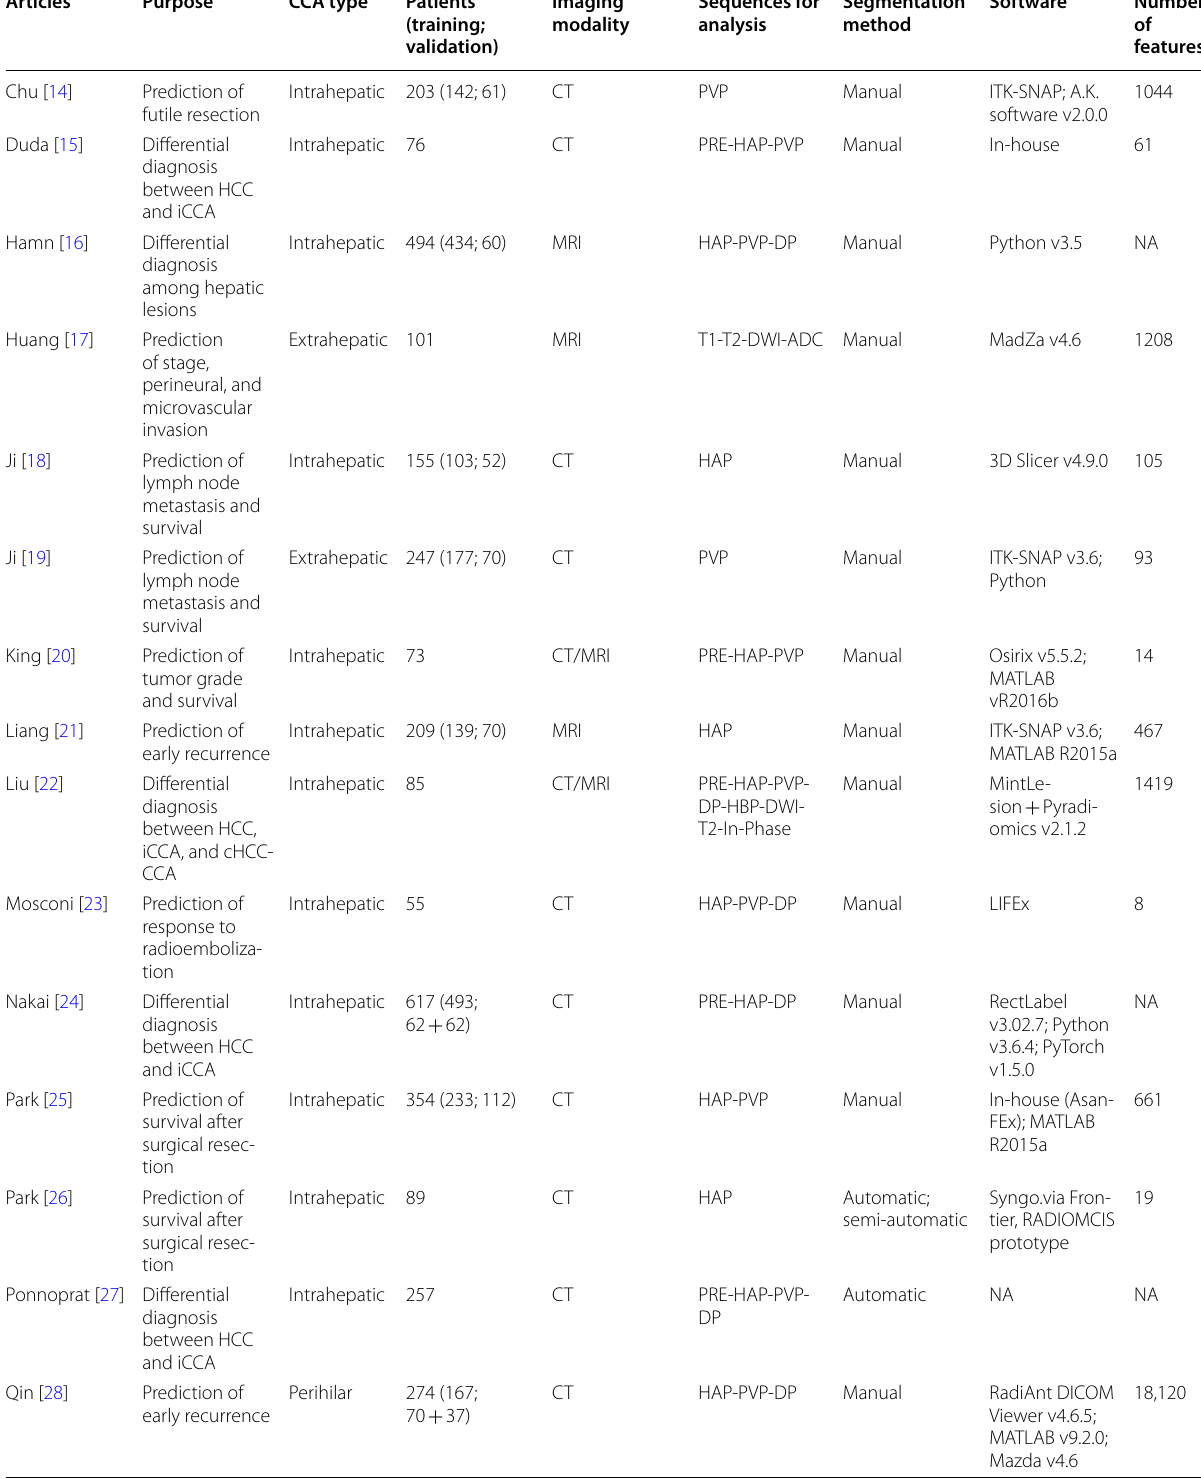
Table 2 Main purposes and methodology of the included studies